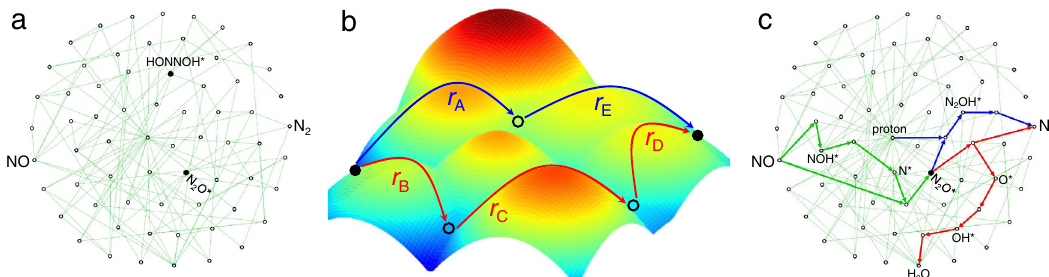
Fig. 2 | A scheme of determining the optimum pathways. a The full reaction network for N 2 production (constructed from Supplementary Table 1), where HONNOH* and N 2 O* are the key intermediates of non-N 2 O* and dis-N 2 O*/p-N 2 O* paths (Supplementary Fig. 7), respectively. b The scheme of global